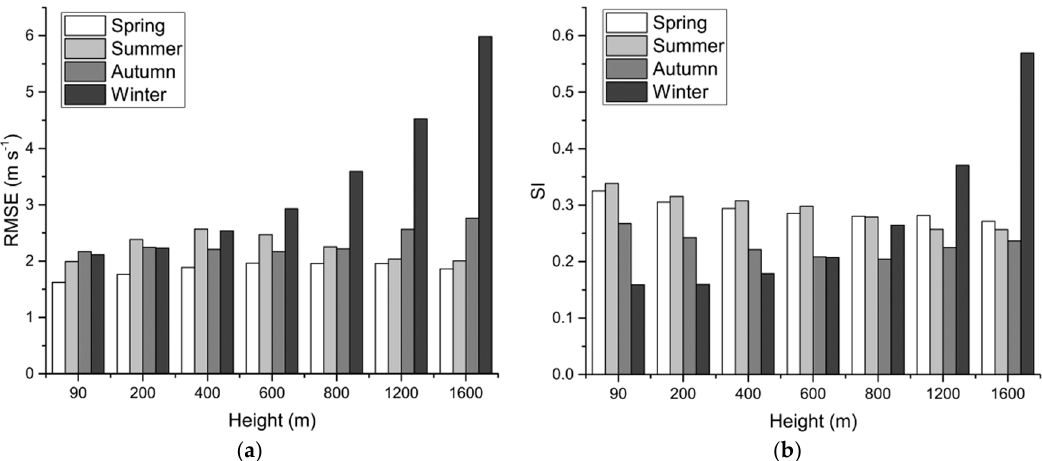
Figure 8. The averaged mean wind profiles in offshore wind farm candidates including the season variations, under normal conditions: ( a ) the RMSE ; and ( b ) the SI . variations, under normal conditions: ( a ) the RMSE ; and ( b ) the SI